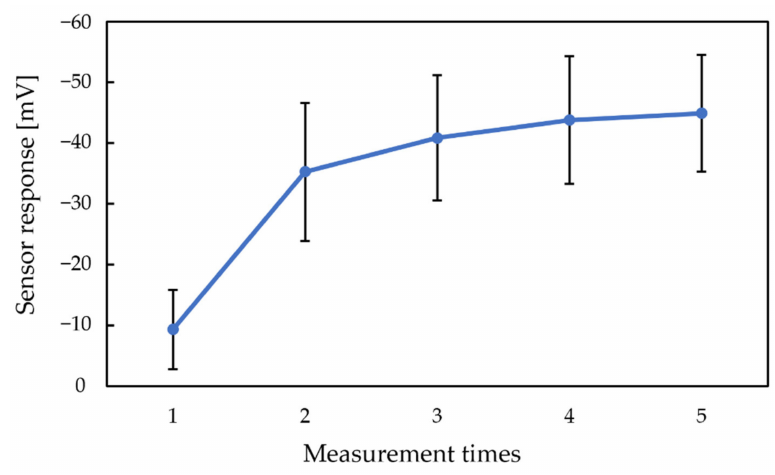
Figure 4. Change in V r during five cycles.